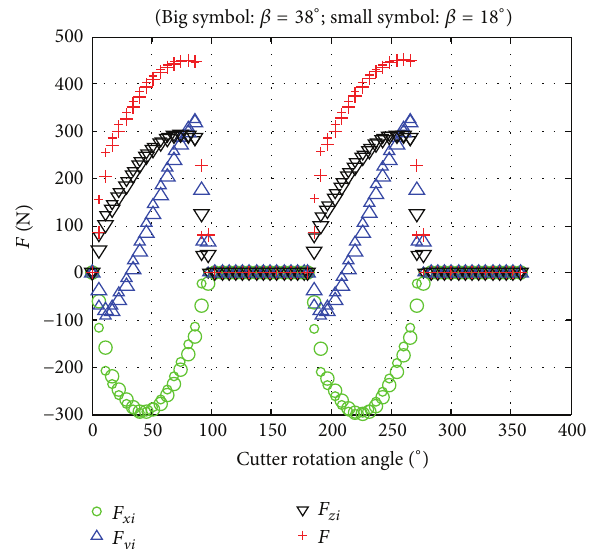
Figure 15: Effect of helix angle on cutting force.